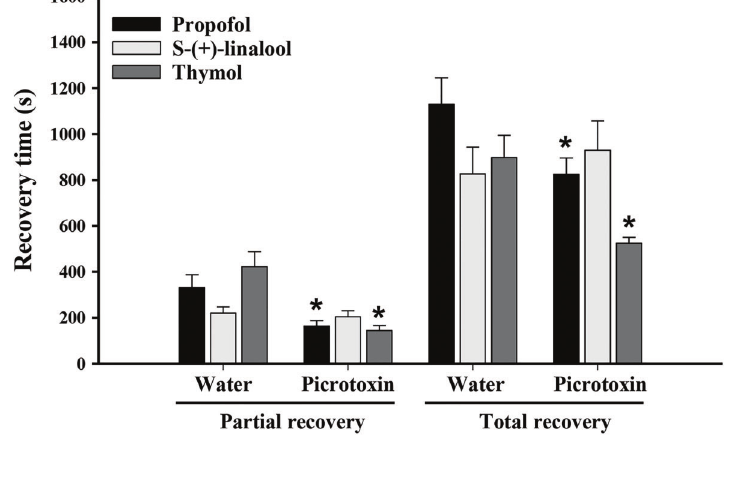
Figure 4. Time required for recovery (partial and total) in water and fl umazenil (3 mg/L) of silver cat fi sh ( Rhamdia quelen ) juveniles anesthetized with diazepam (42 mg/L) and thymol (50 mg/L). Data are reported as means ± SD (n=8). *P o 0.05, compared to the group that recovered in water (two-way ANOVA and Tukey ’ s test).